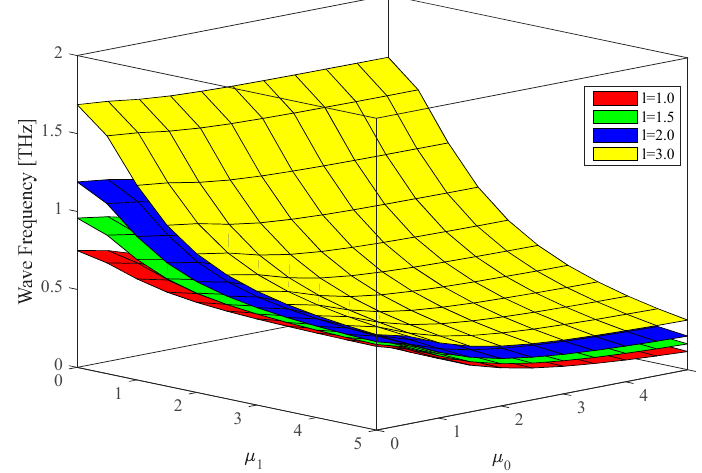
Figure 9. Variation of the wave frequency in P-FGM doubly-curved nanoshells vs. lower/higher order non-local parameters. ( R 2 = R 1 = 50 × h , n = 1, ξ = 0.2, ∆ T = 100, ∆ H = 2 )